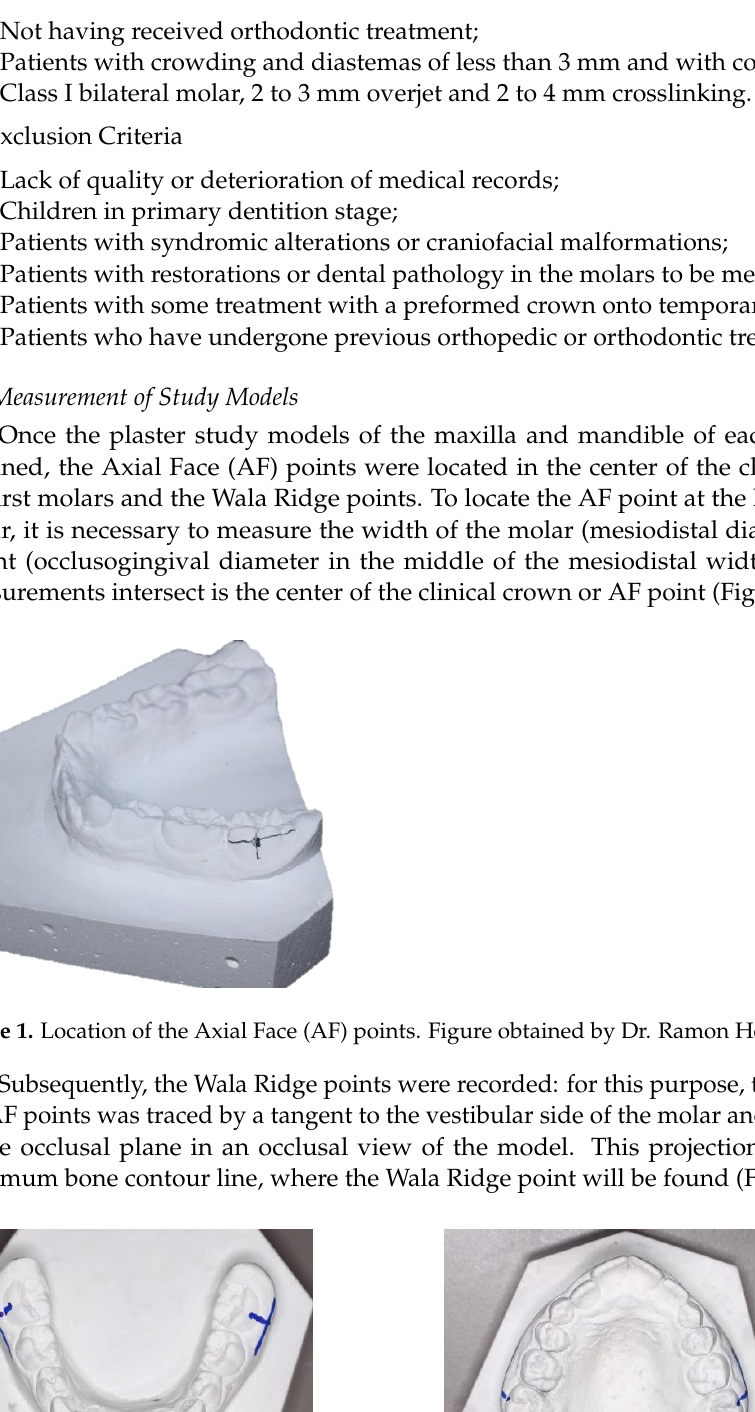
Figure 2. Location of the Wala Ridge points. Figure obtained by Dr. Ramon Herrero R. Once all the points were obtained, and marked with a permanent pen, it was measured with a Mestra ® brand digital caliper with a precision of 1 hundredth of a millimeter; the width between the Wala Ridge points of the right and left first permanent molar was measured to obtain the width of the bony bases. Next, it was observed whether